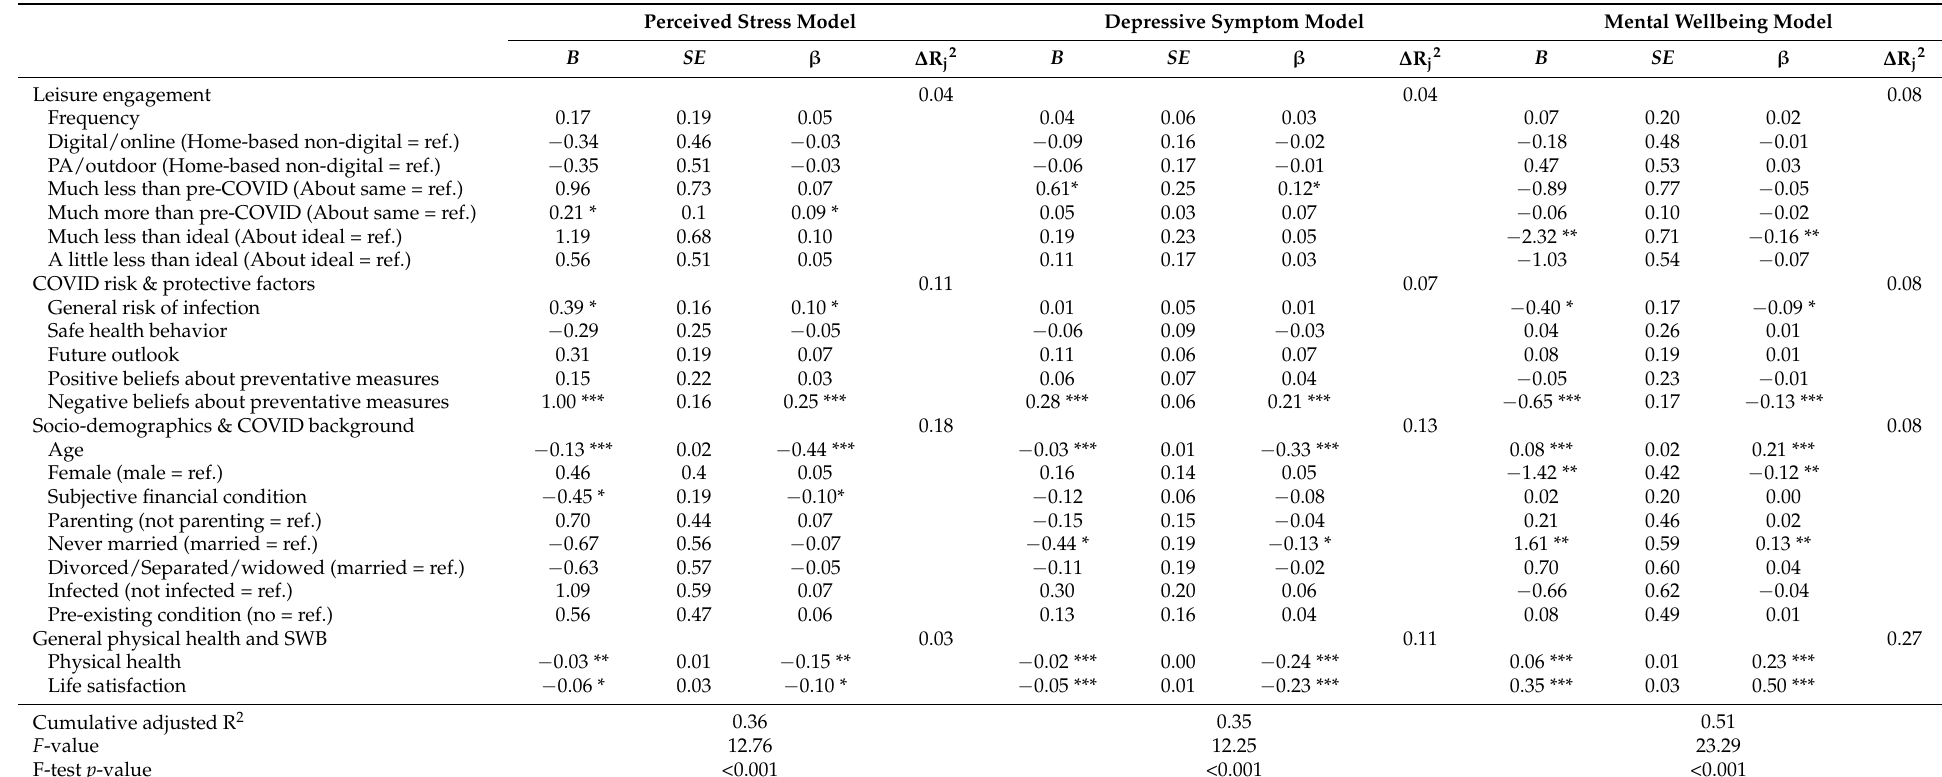
Table 4. Fully adjusted linear regression models of perceived stress, depressive symptoms, and mental wellbeing ( n =